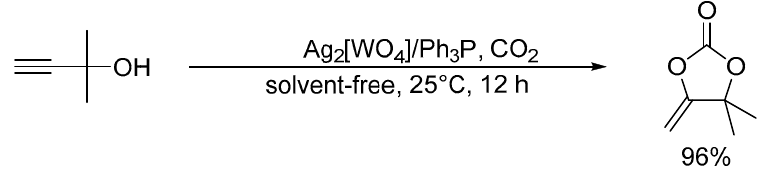
Scheme 4. Chemical fixation of CO 2 with 2-methyl-3-butyn-2-ol catalyzed by Ag 2 [WO 4 ]/Ph 3 P.